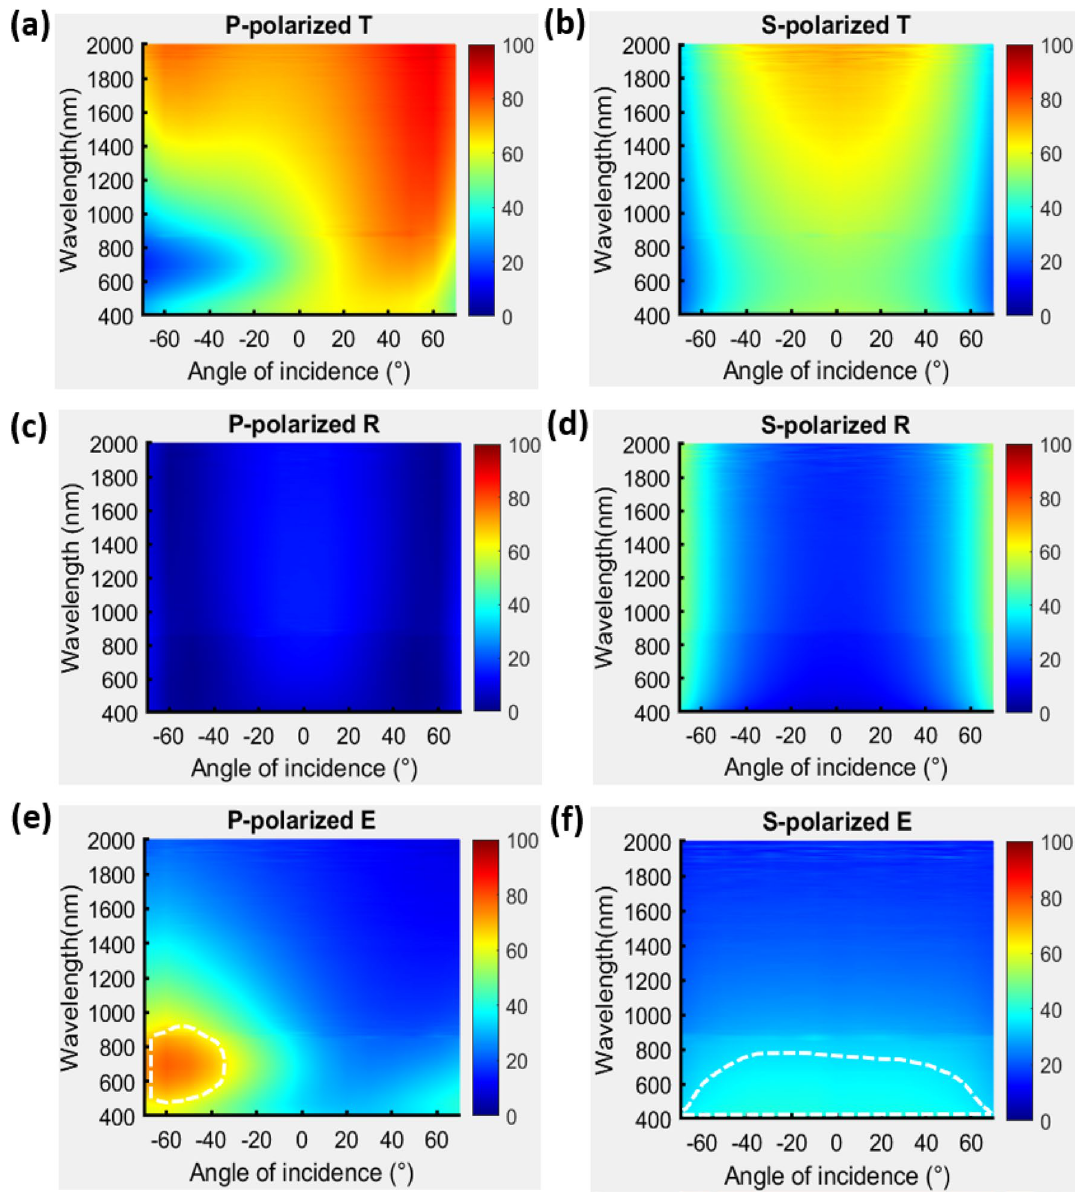
Figure 2. P-polarized and s-polarized transmittance ( a , b ), reflectance ( c , d ) and extinctance ( e , f ) spectra measured at ϕ = 0 ◦ that incident plane is coincident with deposition θ = 0 ◦ , increasing with θ , as is conventional for s-polarized reflection at an interface. The average s-polarized reflectance over the wavelengths and incident angles is 26.16%. Figure 2e,f show the extinctance E, derived from E = 1 − R − T 27,28 . The p-polarized extinctance has a high value of E = 78.1% at θ = − 60 ◦ and (cid:31) = 685 nm ; in this direction, the electric field oscillates along the rods, inducing longitudinal plasmon resonance. The p-polarized extinctance of over 65% is continuously distributed in the area inside the white dash lines in Fig. 2e. When an s-polarized incident wave is incident on a tilted nanorod array, the electric field usually oscillates perpendicular to the rods at all angles of incidence, and trans- verse plasmon resonance is induced over a wide range of angles at a wavelength of close to 400 nm. Therefore, s-polarized extinctance is strong at 400 nm over a wide range of incident angles. An s-polarized extinctance of over 35% is continuously distributed in the area inside white dash lines in Fig. 2f. Figure 3 shows the p-polarized